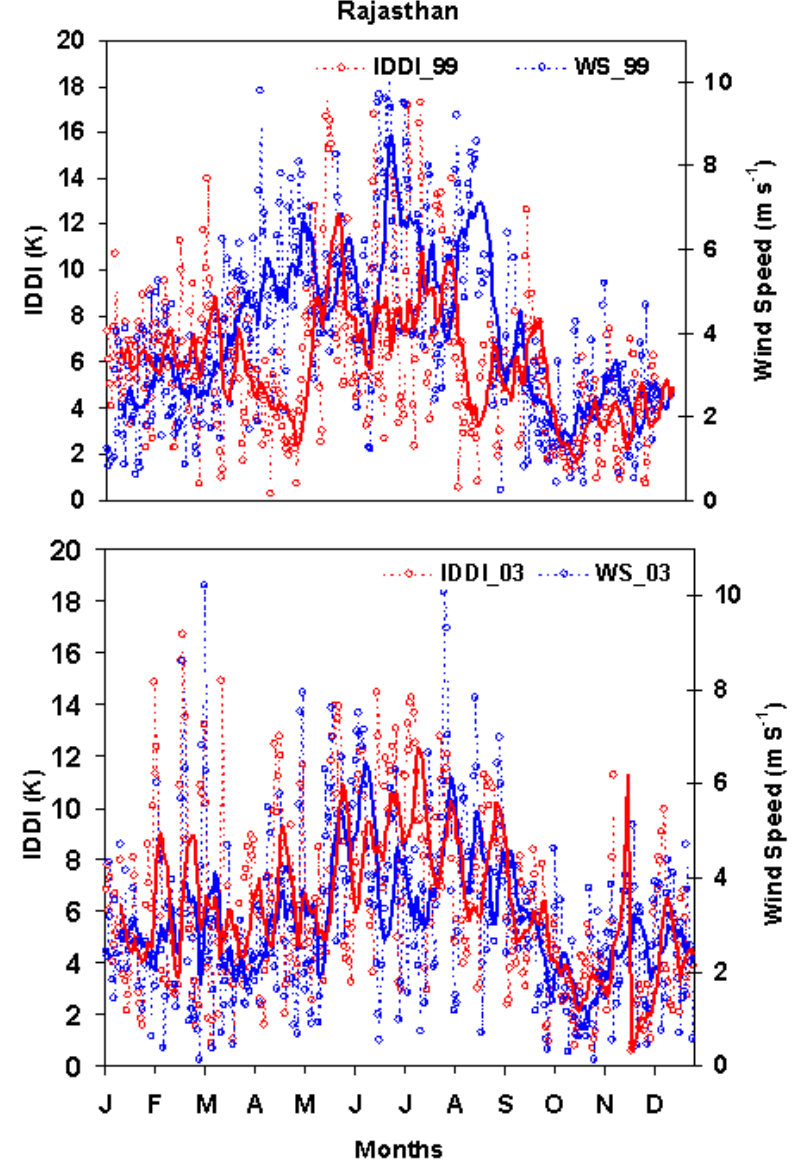
Fig. 6. Daily IDDI and wind speed (dashed lines) for Rajasthan. Solid line represents 10-day running average.